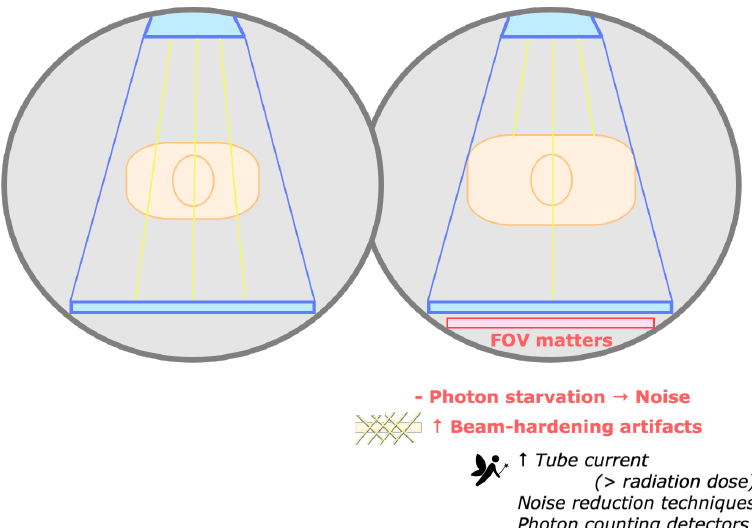
Figure 12. Impact of patient size in DECT image quality. Larger bodies may increase the image noise and reduce the image quality (given the insufficient number of photons reaching the detectors, rep- resented by yellow lines). Beam hardening artifacts are more pronounced in larger patient sizes. Potential strategies to improve image quality include increasing the tube current and using noise reduction techniques. Noise is also reduced with the novel photon-counting scanners. The limited field of view (FOV) for dual-energy imaging in dual-source scanners may be a problem in larger patients. As photon starvation is more marked at low kVp, this problem is more apparent with DECT scanners restricted to a low-energy option of 80 kVp (e.g., rapid kVp switching and some dsDECT scanners) [14,28]. Image quality may be improved by increasing the tube